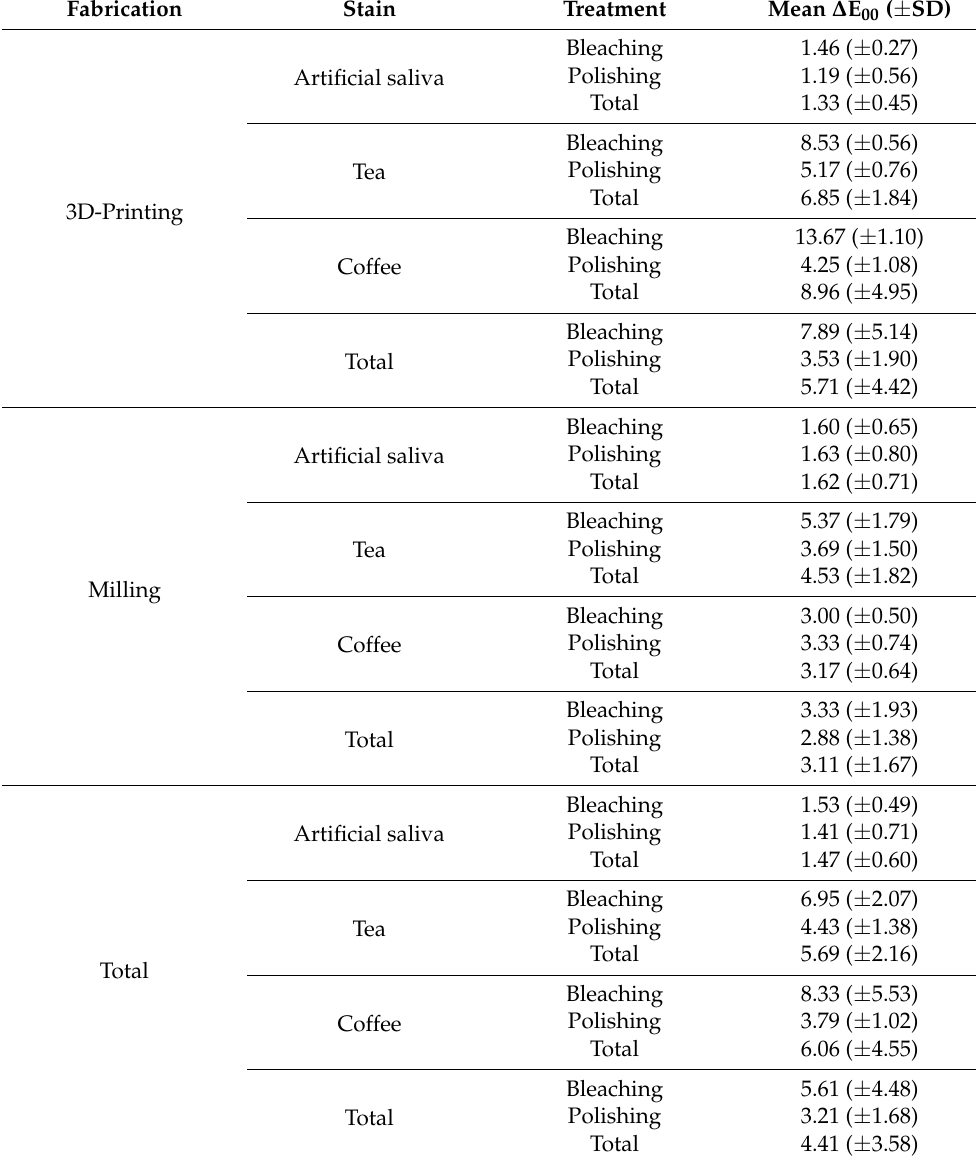
Table 3. Mean and SD of ∆ E 00 after subjecting stained specimens to in-office bleaching and surface polishing